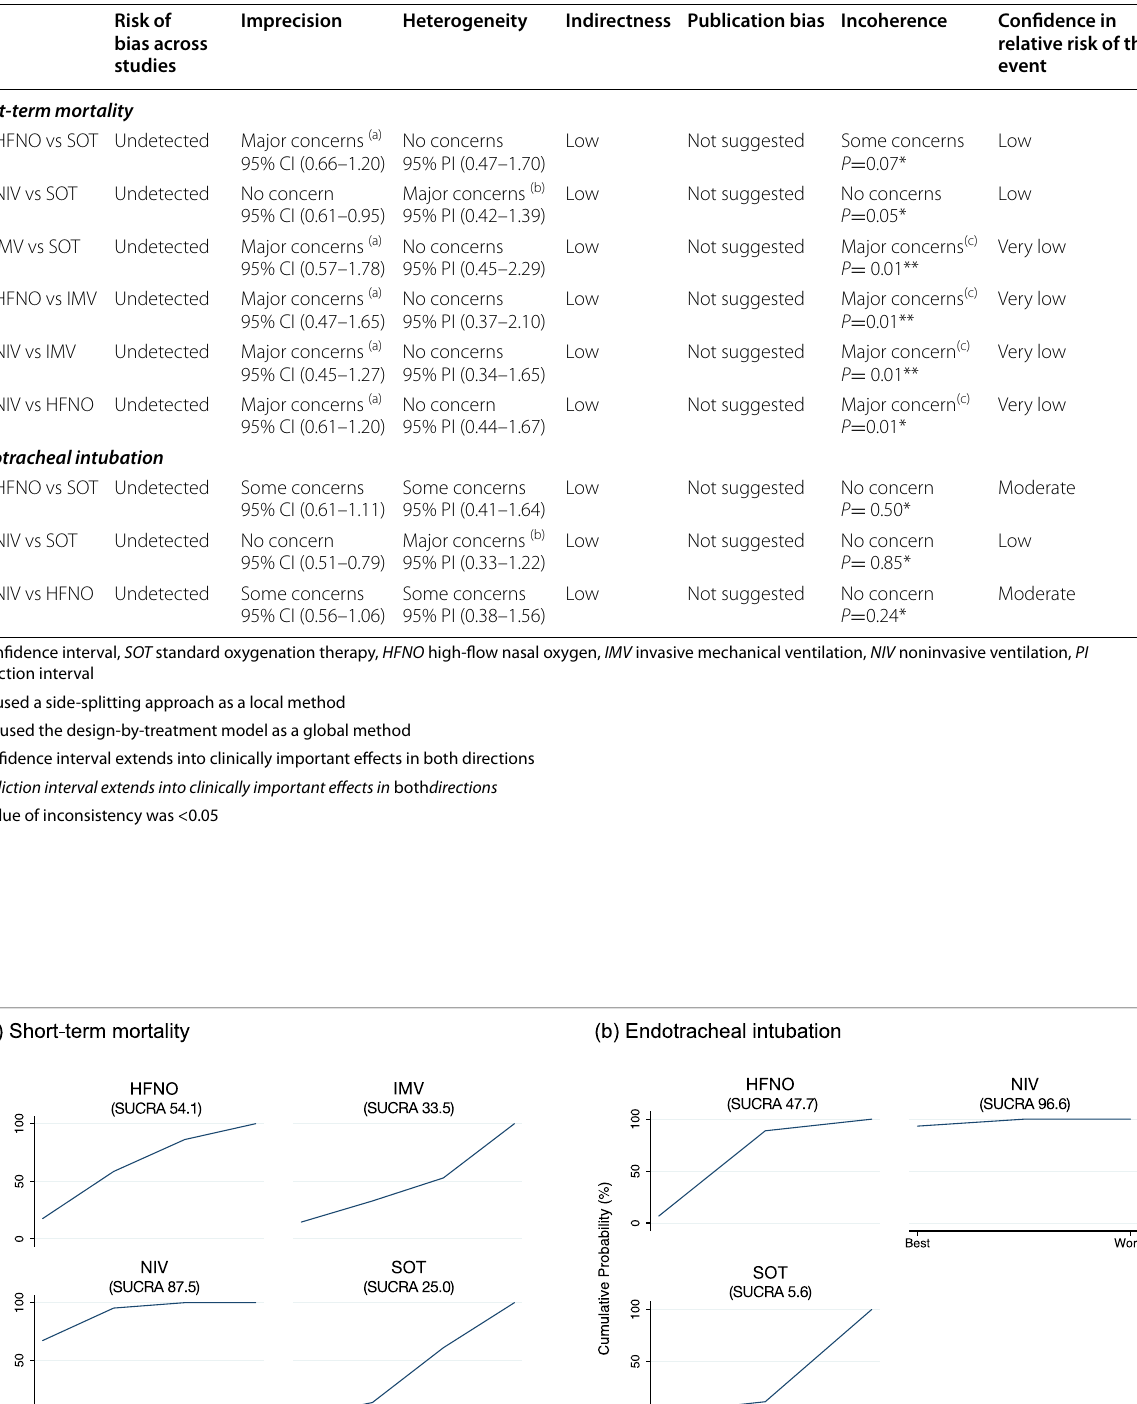
Table 2 Confidence assessment in the risk ratio of each comparison and outcome